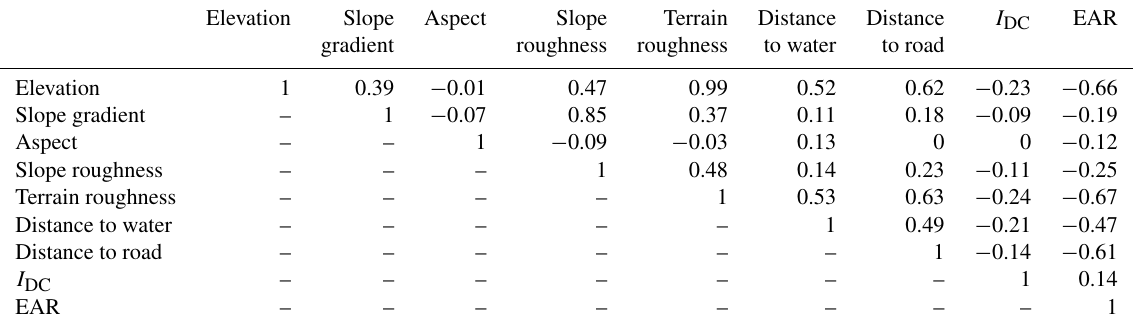
Table 5. Correlation test results between the predisposing